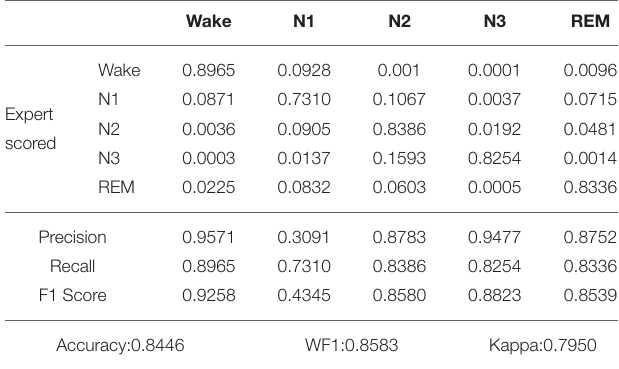
TABLE 5 | Confusion matrix and classification performance of proposed model applied on our own dataset after increasing the weight of the N1 state. Wake